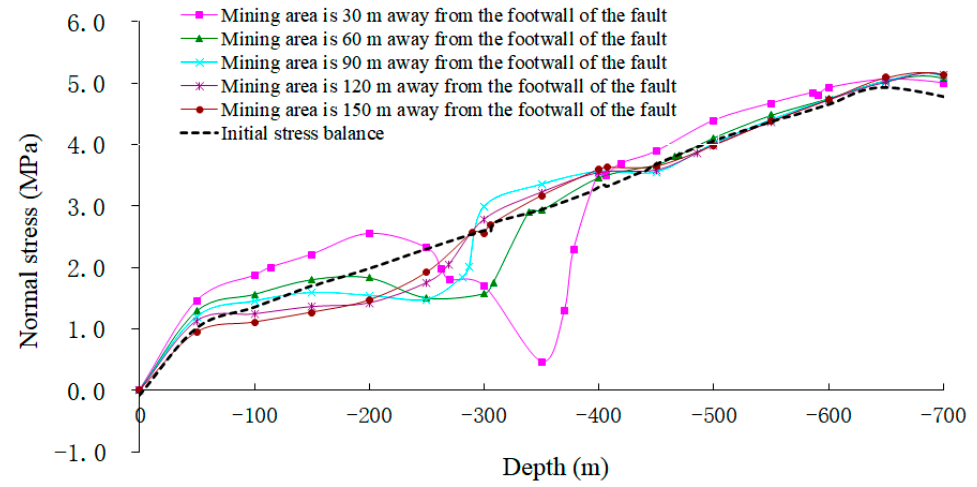
Figure 9. When the mining area is situated within the fault footwall, the normal stress distribution on the fault plane at various locations. on the fault plane at various